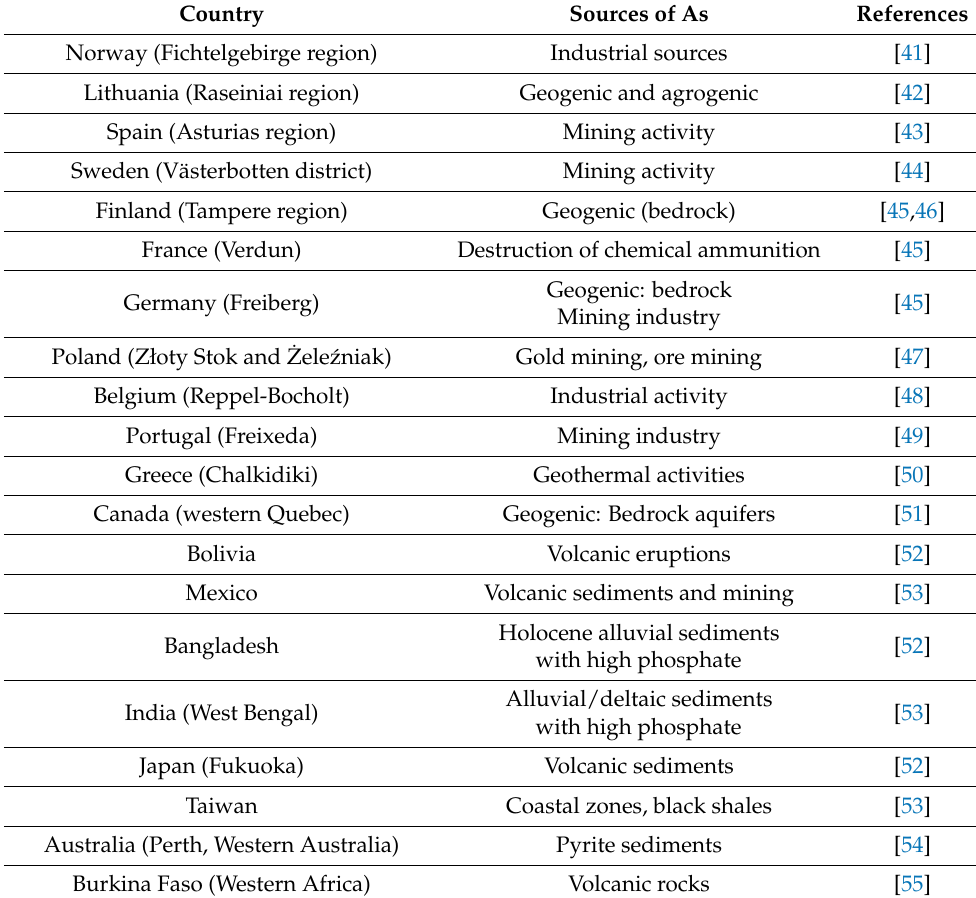
Table 7. Sources of arsenic contamination in different countries in the world